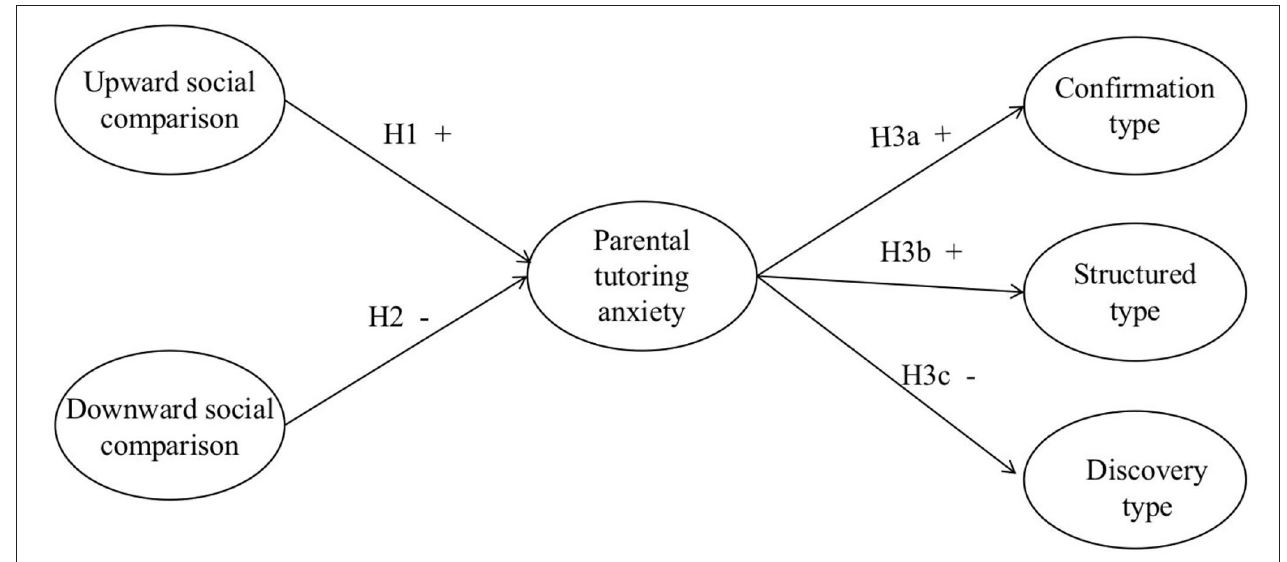
FIGURE 1 | Hypothesized research